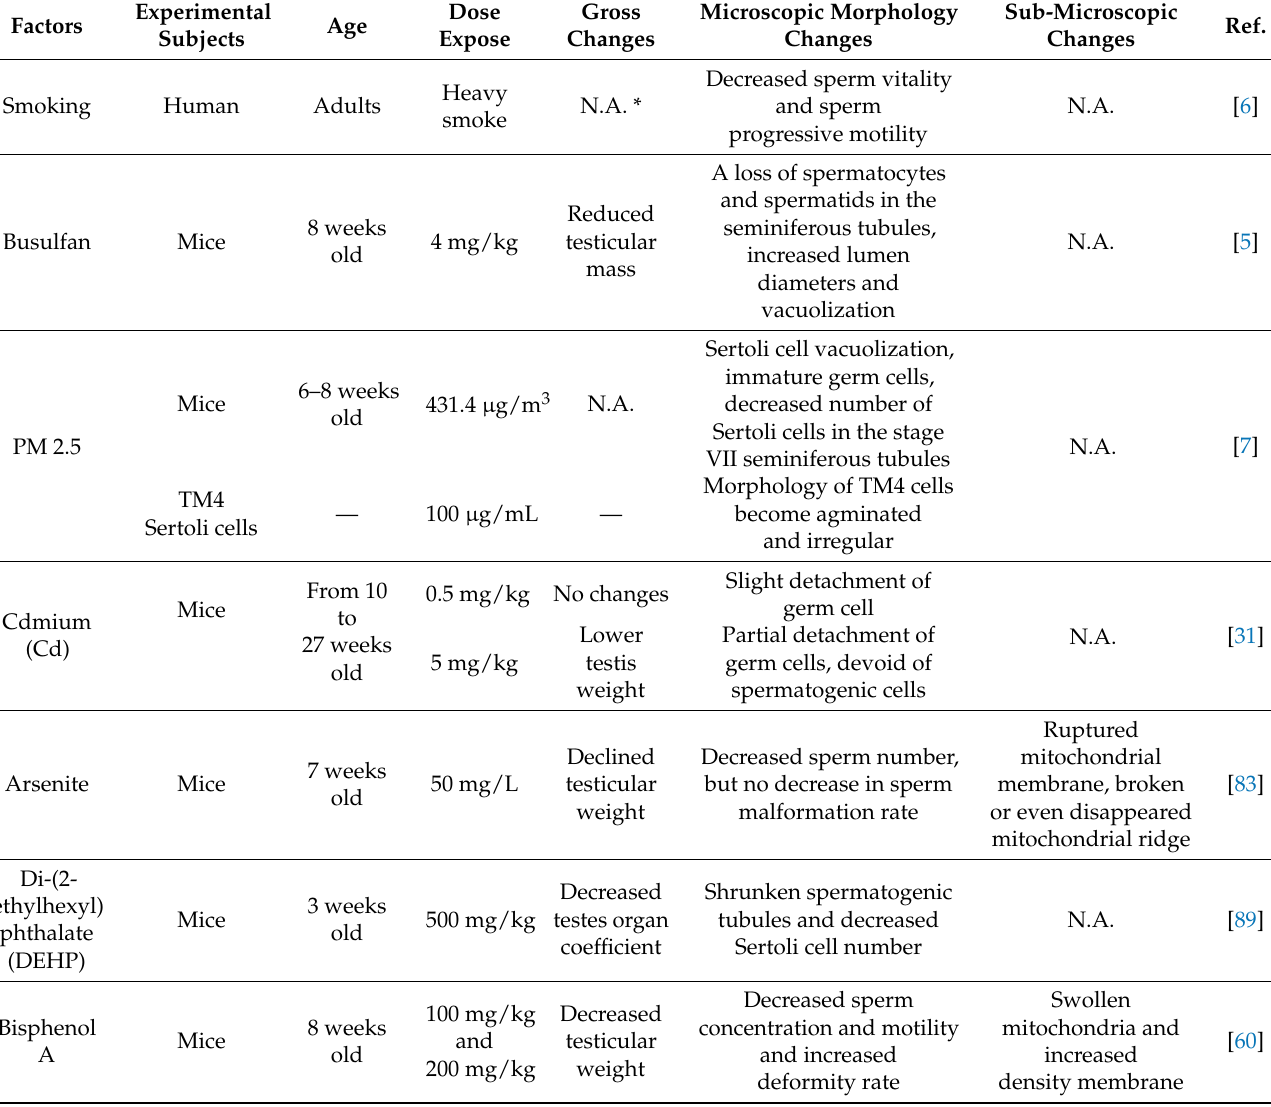
Table 1. Morphological changes in testicular tissue induced by risk